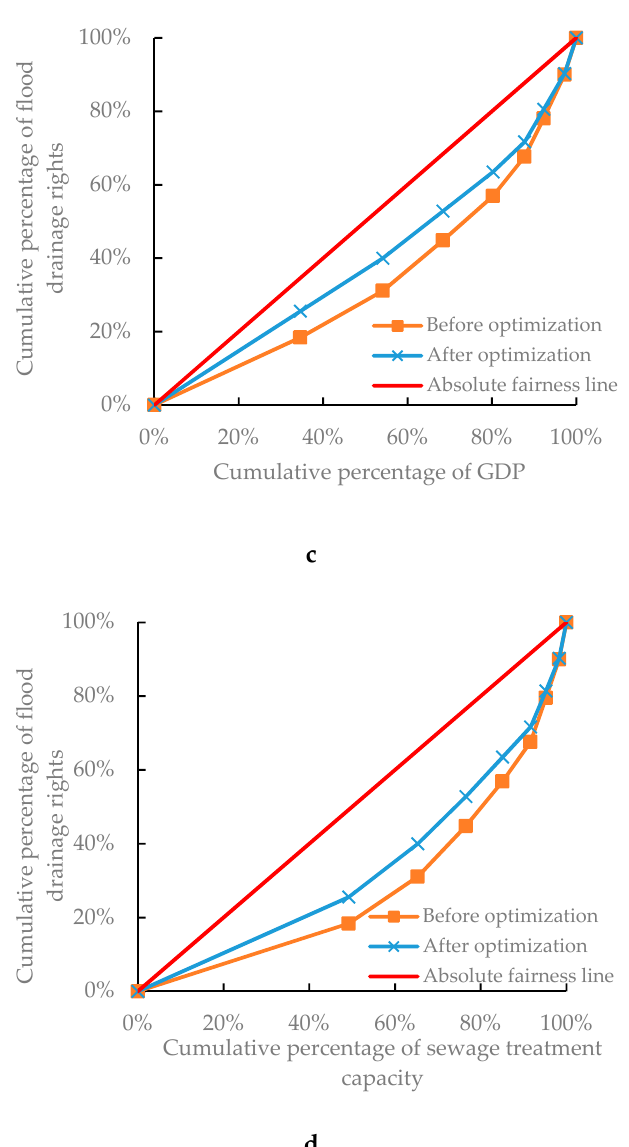
Figure 7. Lorenz curves of each index before and after optimization; ( a ) Lorenz curve based on land area; ( b ) Lorenz curve based on total population; ( c ) Lorenz curve based on GDP; ( d ) Lorenz curve based on sewage treatment capacity.